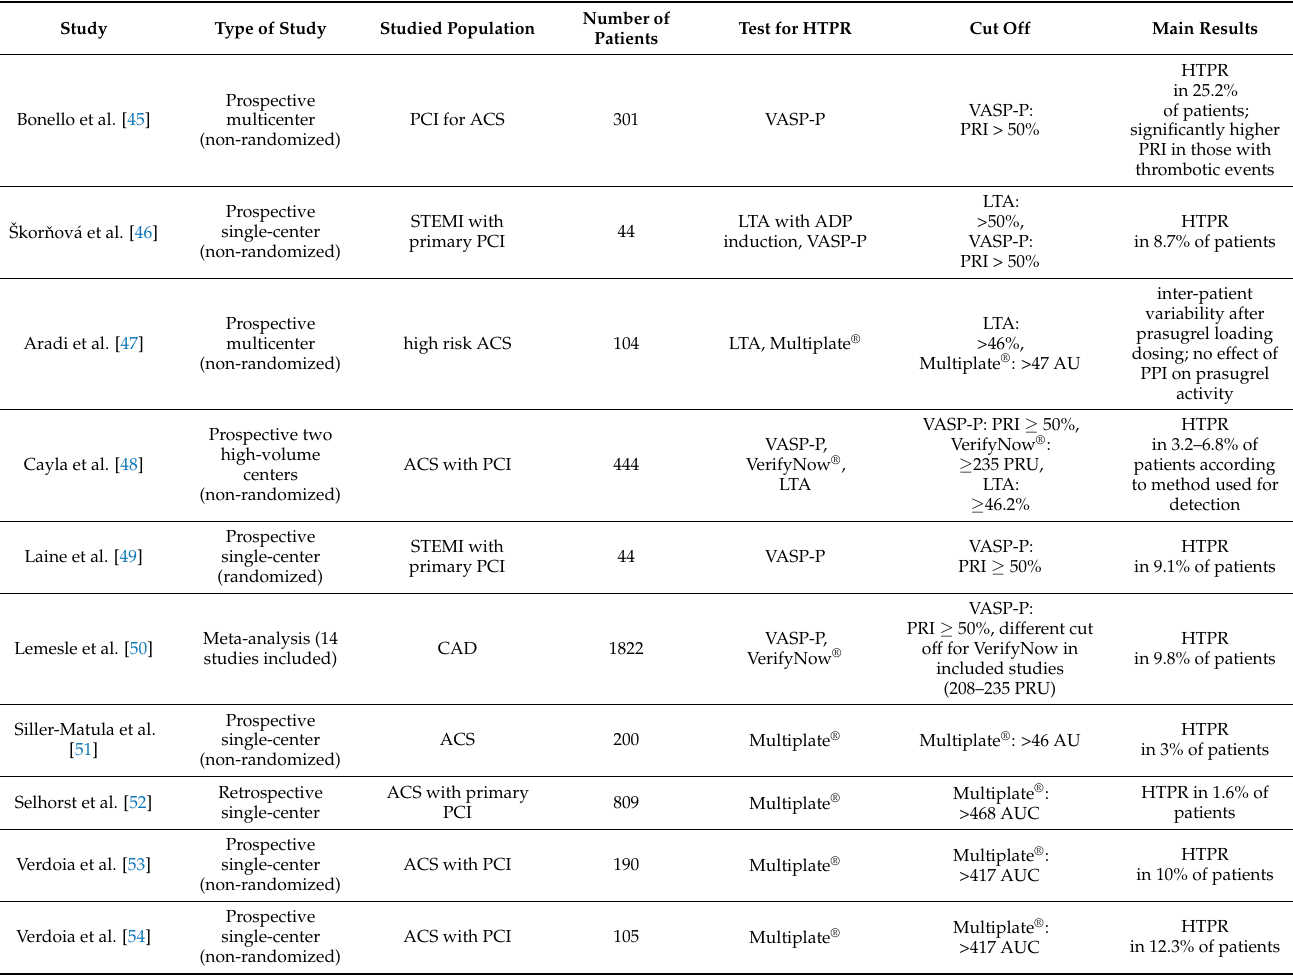
Table 2. Summary of studies reporting prasugrel